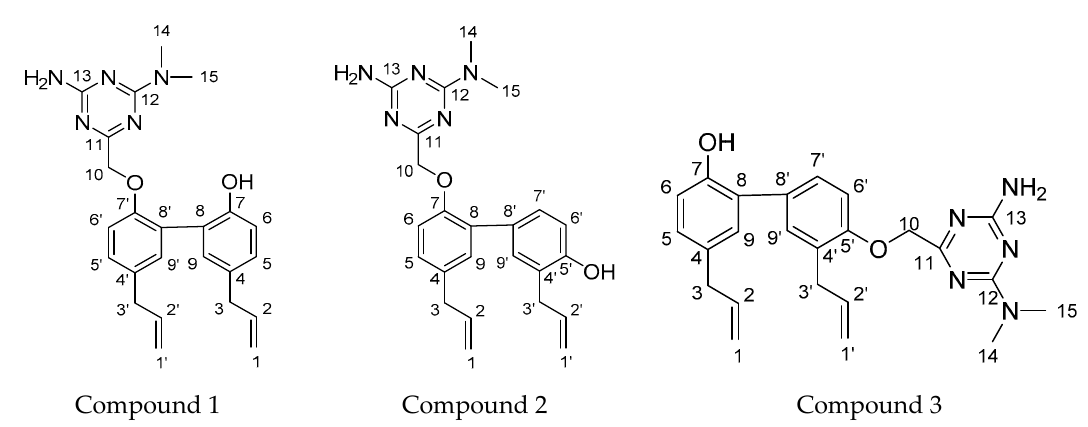
Figure 1. The structures of magnolol, honokiol, metformin, and compound 1, 2, 3.